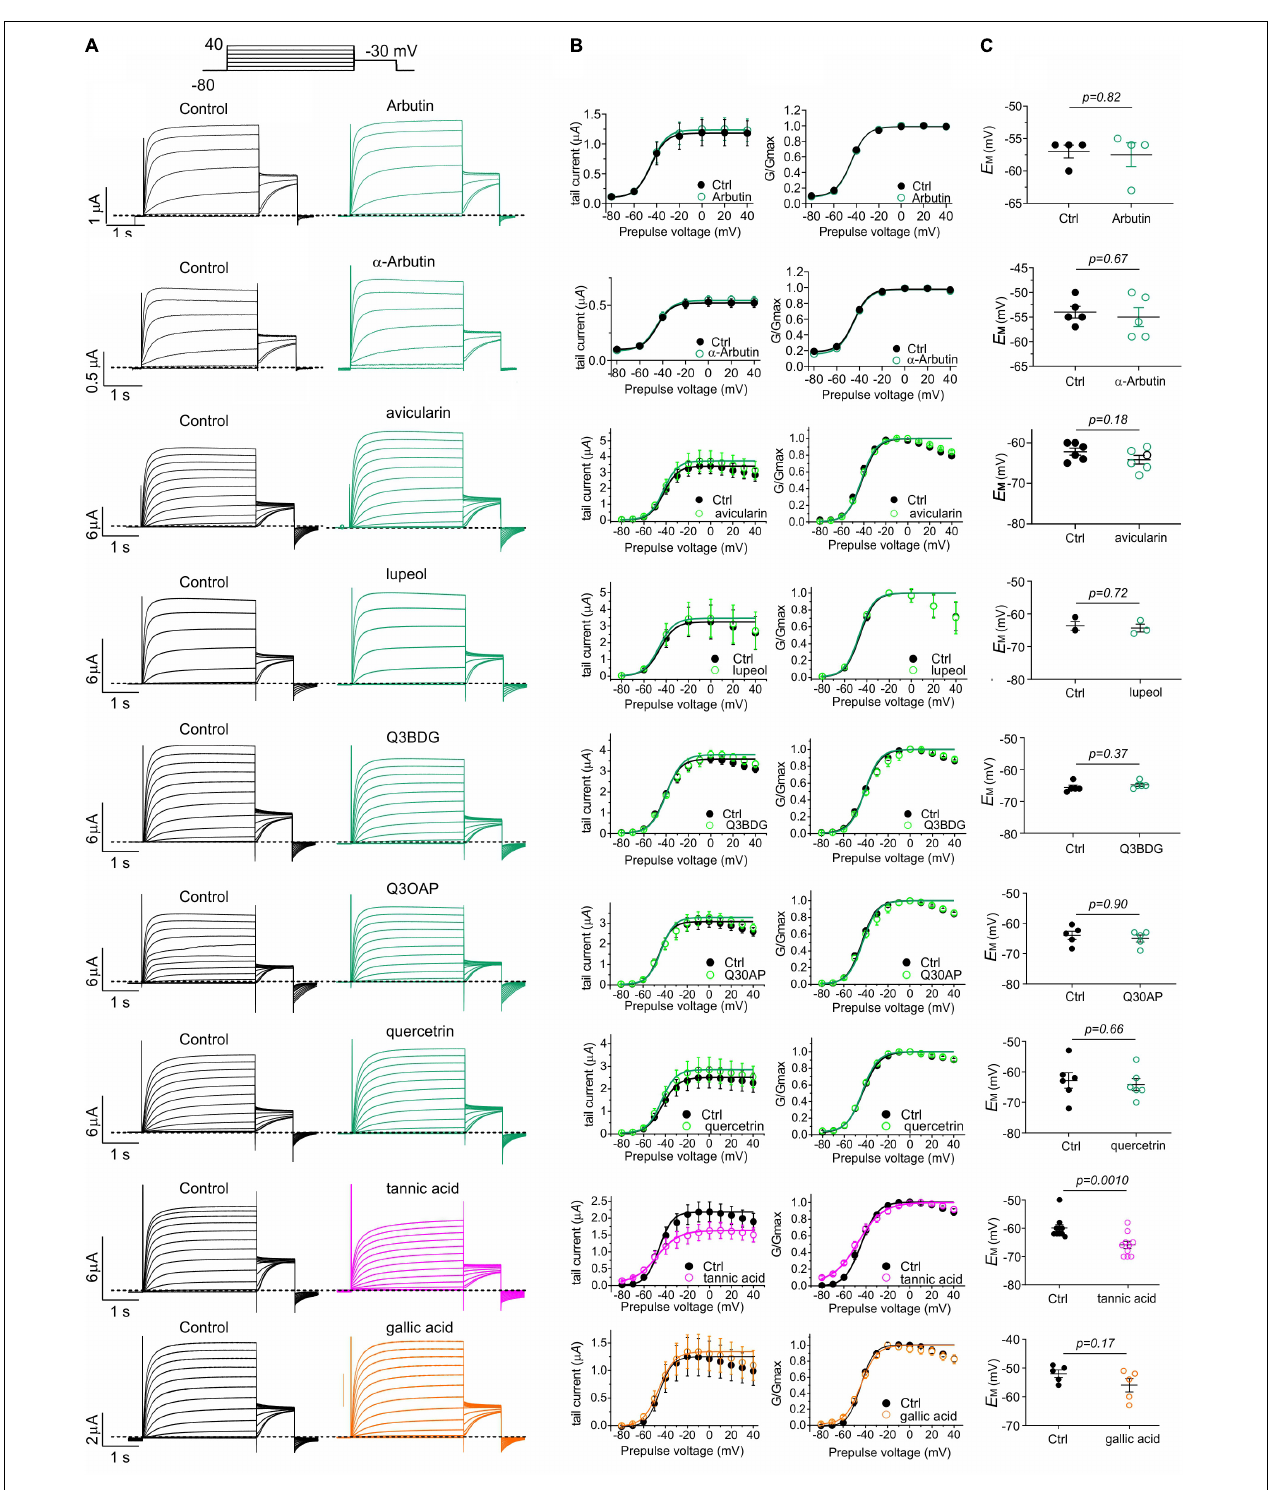
FIGURE 5 | Tannic and gallic acid but not other Muir Woods plant compounds tested activate KCNQ2/3. All error bars indicate SEM. n = number of oocytes. (A) Exemplar TEVC traces of oocyte-expressed KCNQ2/3 in the absence (Control) and presence of 100 µ M concentrations of compounds in Muir Woods plant “hits” ( n = 3–10). Upper inset: voltage protocol. Q3BDG, quercetin 3- β - D -glucoside; Q3OAP, quercetin 3-O- α - L -arabinopyranoside. (B) Mean tail current and normalized tail currents (G/Gmax) versus prepulse voltage relationships for the traces as in panel (A) . (C) Scatter plot of unclamped membrane potential ( E M ) for Xenopus oocytes expressing KCNQ2/3. Statistical analysis by two-way ANOVA.